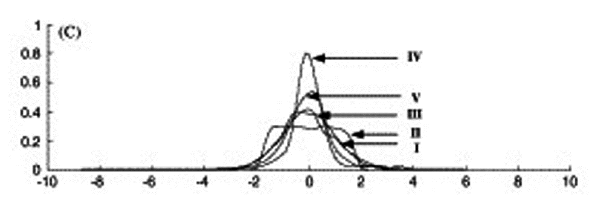
Fig. 1: Examples of captured EEG distribution.